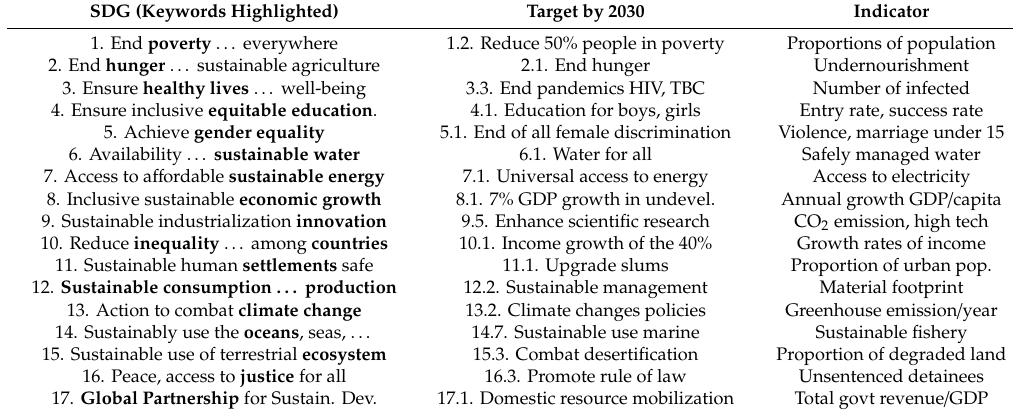
Table 1. Selective overview of 17 Sustainable Development Goals (SDGs) with 169 targets and 244 indicators. SDG (Keywords Highlighted) Target by 2030